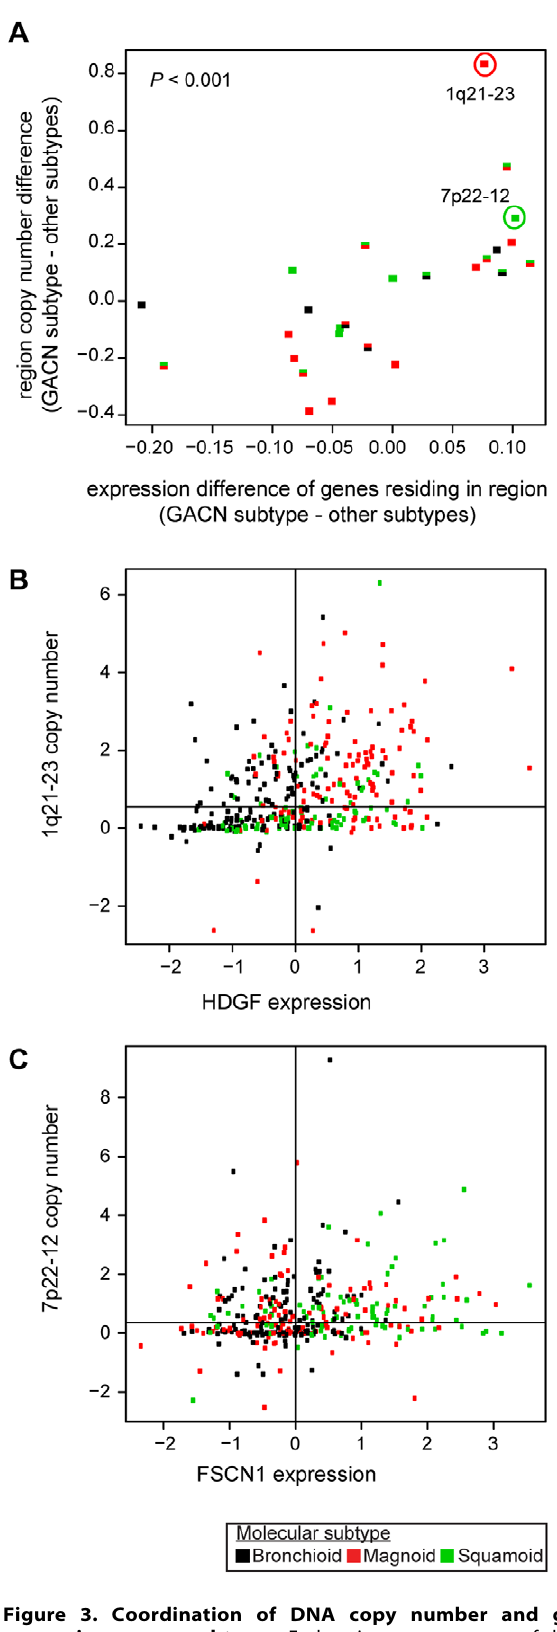
Figure 3. Coordination of DNA copy number and gene expression among subtypes. Each point represents one of the 26 subtype-associated copy number (CN) regions, which are colored by the subtype having the greatest absolute copy number (GACN).